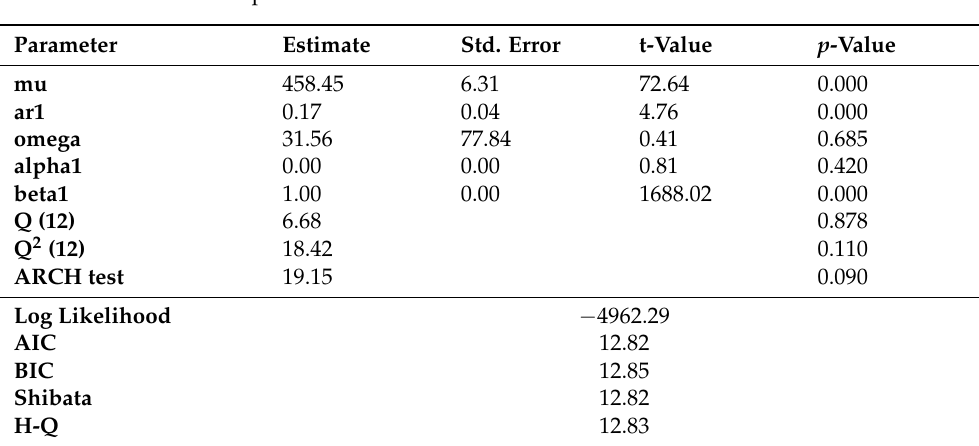
Table 5. ARMA-GARCH parameters estimation.